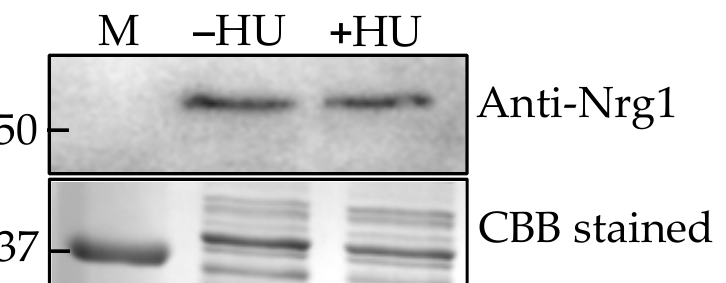
Figure 7. Nrg1p expression in C. auris treated with hydroxyurea (HU). Western analysis of cytosolic proteins from C. auris against Cal Nrg1 antibody ( upper panel ). Lane 1. Marker, Lane 2. Without HU, and Lane 3. With HU. SDS-PAGE gel of proteins from C. auris cells grown in sweat medium with and without HU followed by Coomassie brilliant blue (CBB) staining ( lower panel